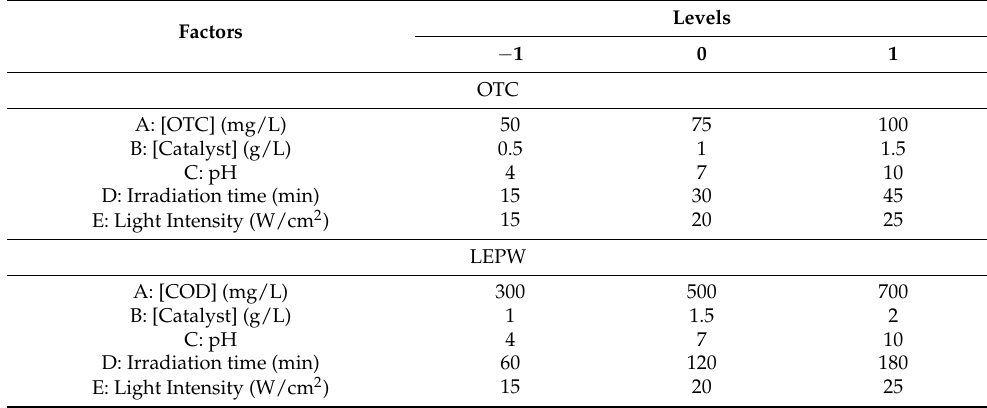
Table 2. Experimental ranges and levels of the processing factors for OTC and COD removal.